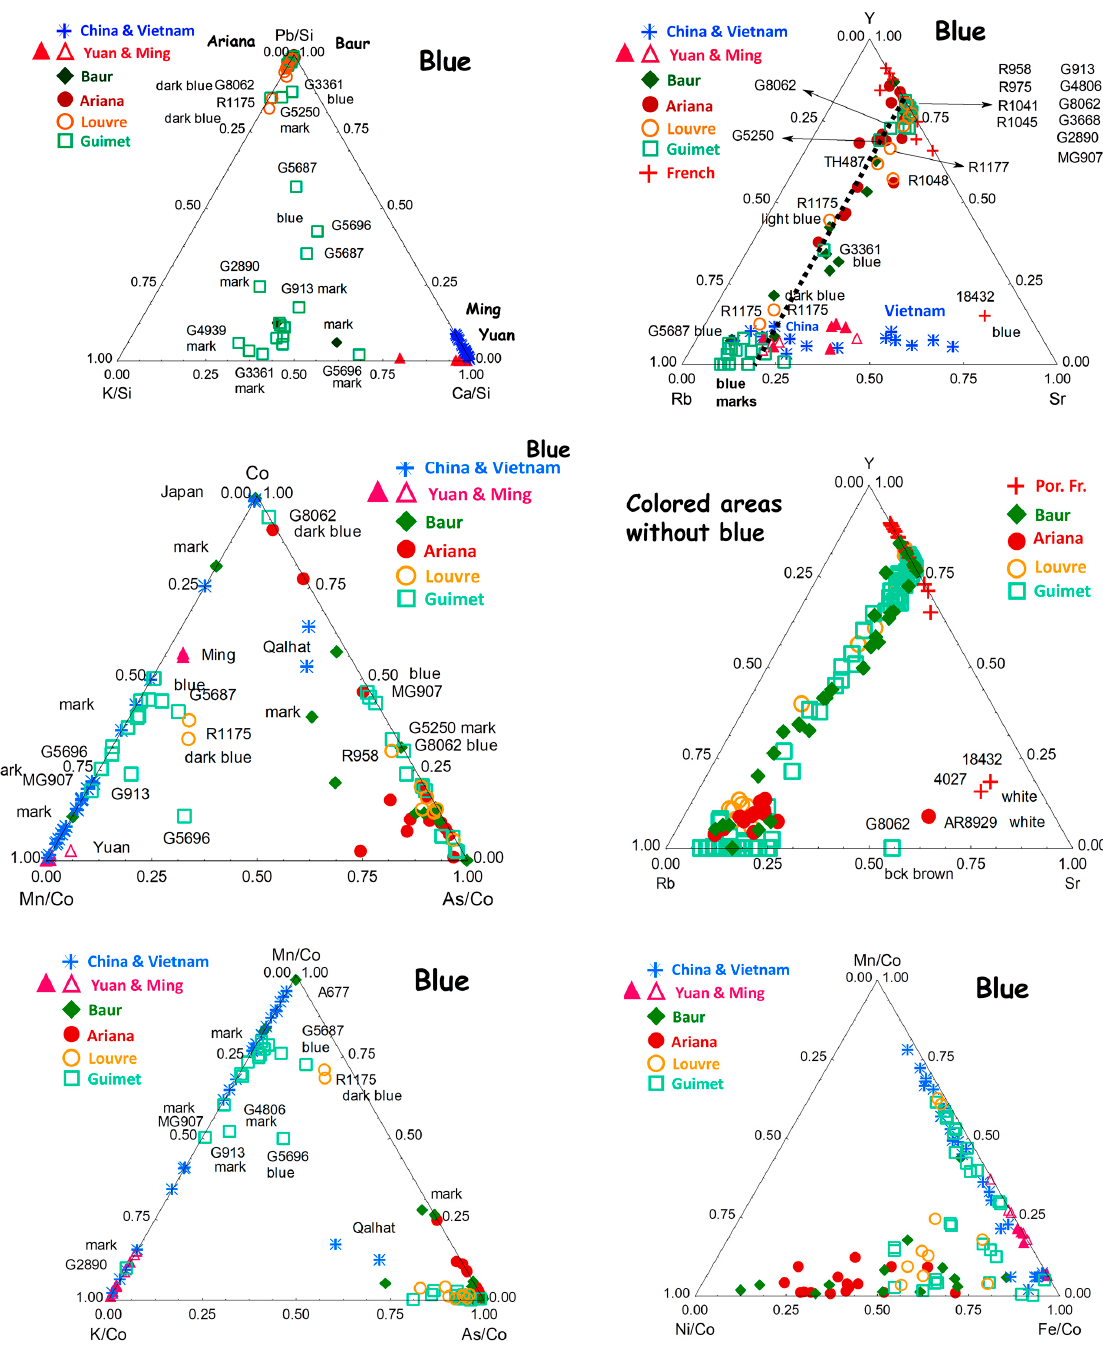
Figure 10. Comparison of signal of elements associated with the blue colored areas for artifacts from different origins: Yuan and Ming Dynasty Private Museum Collection [17,18], archaeological shards issued from sites from Ming Dynasty period [19], Baur Foundation Collection [15,16], Ariana Museum Collection [15,16], French porcelain [30] and present study (Louvre and mnaa-Guimet museum Collections). A comparison is made with other colored areas.